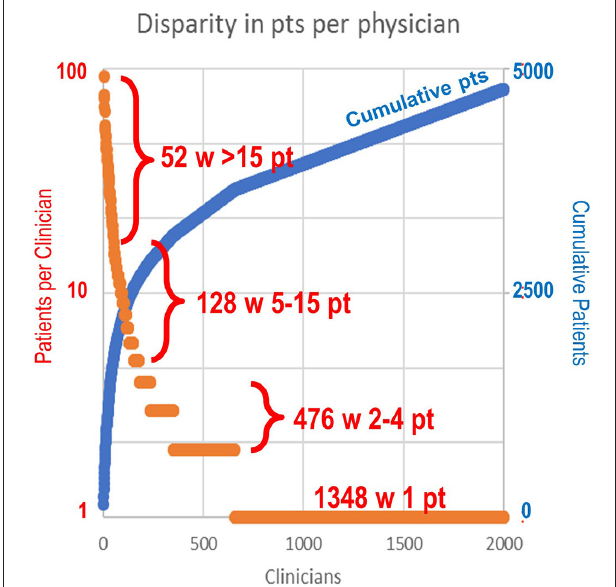
FIGURE 1 | Range of patient volume per clinician. The 52 clinicians (2.6%) with > 15 patients each (mean 41.3) treated 44% of total patients. The next 128 clinicians each treated 5–15 patients. A total of 476 clinicians treated two to four patients each. A total of 1,348 clinicians had only a single patient.